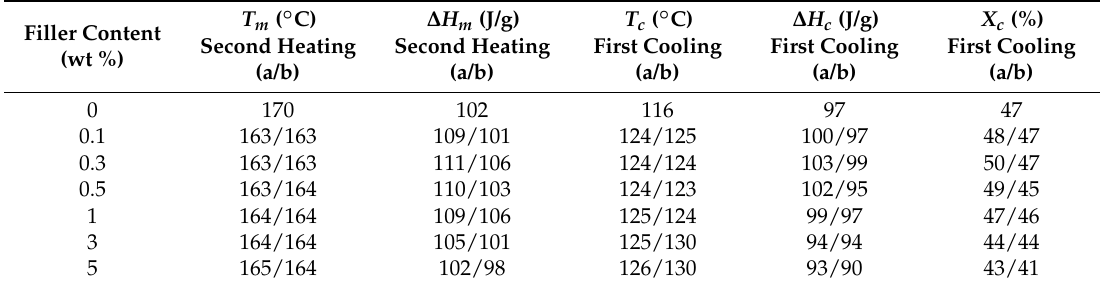
Table 3. Melting temperature ( T m ) and enthalpy of melting ( ∆ H m ) from the second heating; crystallization temperature ( T c ), enthalpy of crystallization ( ∆ H c ), and crystallinity ( X c %) from the